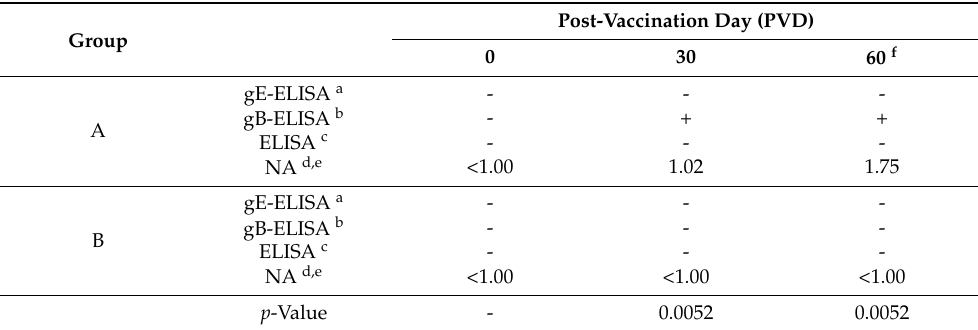
Table 2. Antibody response of water buffaloes immunized against BoHV-1 using an inactivated gE-deleted marker vaccine.